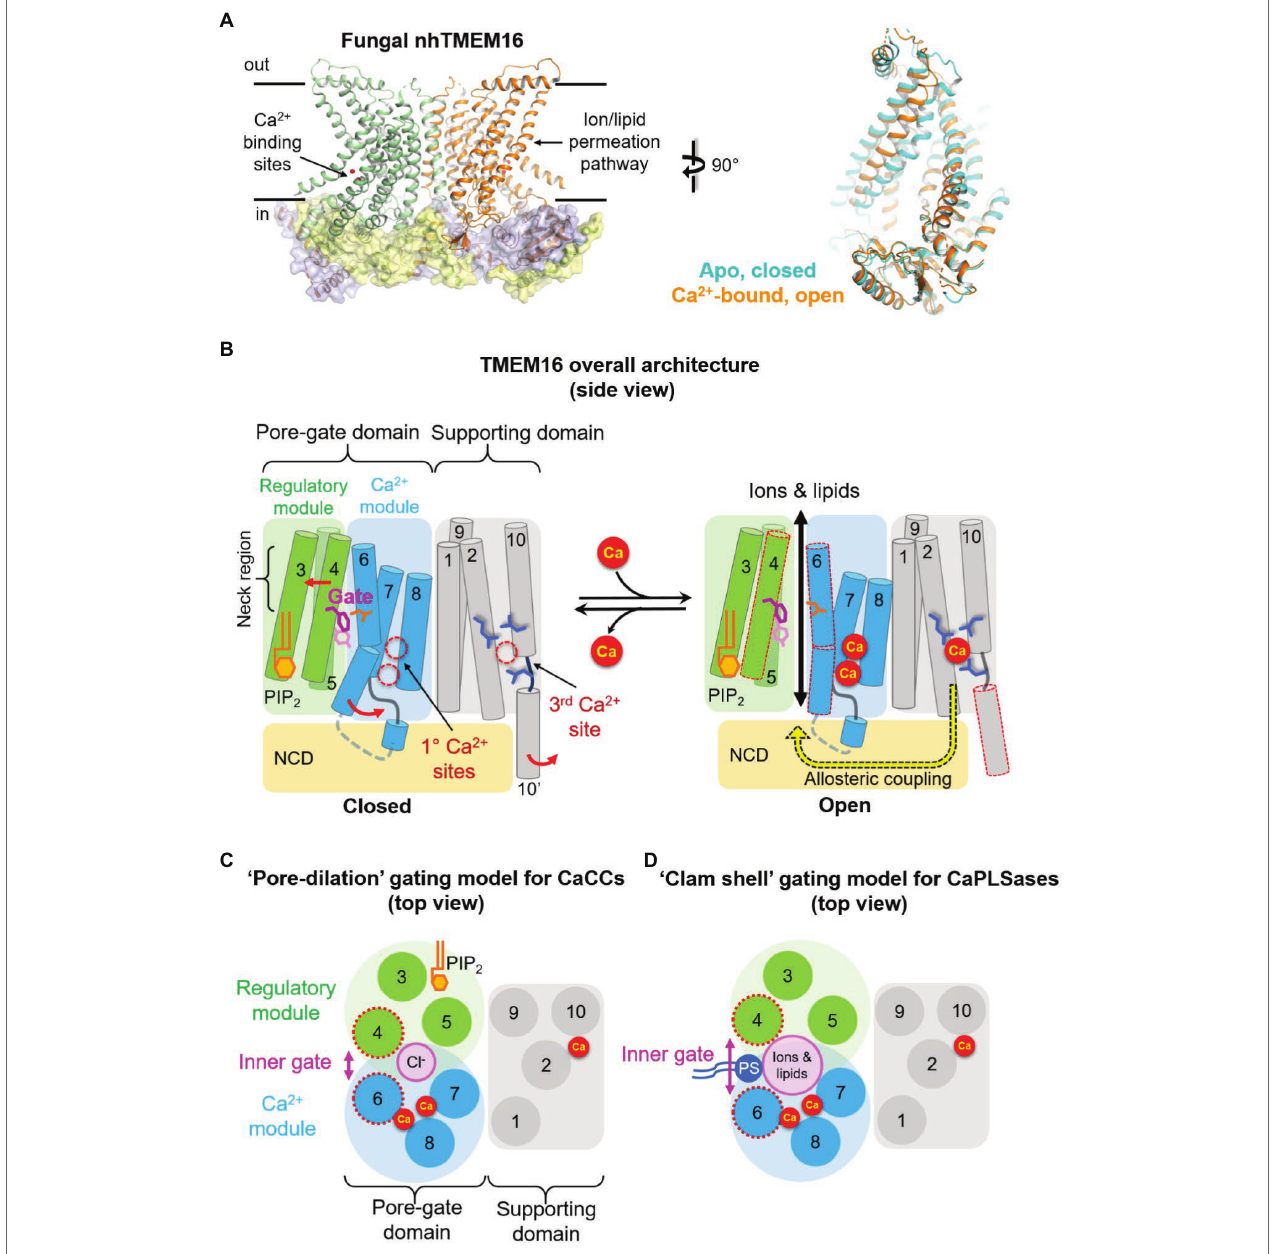
FIGURE 1 | Architecture of TMEM16 proteins. (A) Left: X-ray structure of the fungal nhTMEM16 bound to Ca 2+ (PDB: 4WIS). Right: comparisons of the permeation pathway from cryo-EM structures of nhTMEM16 in an apo, closed state (cyan, PDB: 6QM4) and Ca 2+ -bound, open state (orange, PDB: 6QM9). (B) A simplified cartoon showing the overall architecture (side view) and the “modular design” model of TMEM16 proteins. Three sidechains in the middle of the pore represent the inner activation gate residues (F518, Y563, and I612) of TMEM16F CaPLSase. The putative conformational changes induced by Ca 2+ binding and subsequent activation gate opening are shown on the right. The neck region refers to the narrowest region of the permeation pathway. NCD, N-terminal cytosolic domain; PIP 2 , PI(4,5)P 2. (C) A top view at the level of the inner activation gate showing the “pore-dilation” gating model for TMEM16 CaCCs. According to this model, Ca 2+ - induced conformational changes dilate the permeation pore without separating the TM4/TM6 interface. In this way, only Cl − ions but not phospholipids permeate through the protein-enclosed activation gate. (D) A top view at the level of the inner activation gate showing the “clam-shell” gating model for TMEM16 CaPLSases. According to this model, Ca 2+ -induced conformational changes lead to the separation of TM4 and TM6 at the neck region, resulting in a semi-open pore that faces the lipid core of the membrane. This clam shell-like opening enables phospholipid headgroups to access and subsequently permeate through the